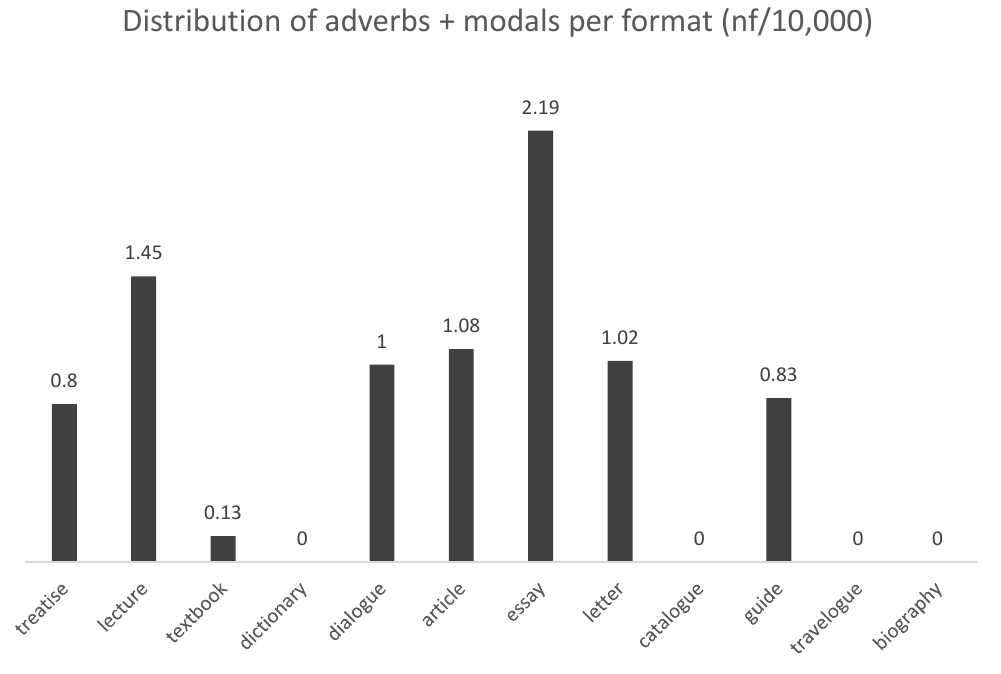
Figure 6. Use of perhaps with modals per sex.